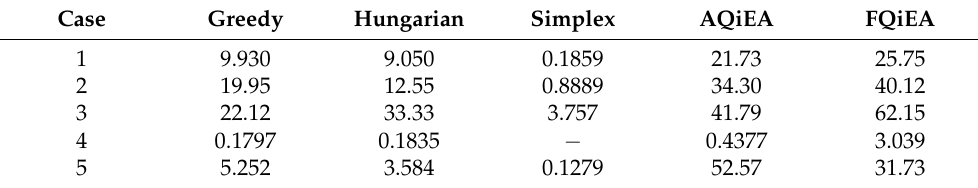
Table 7. Quality metric for the case